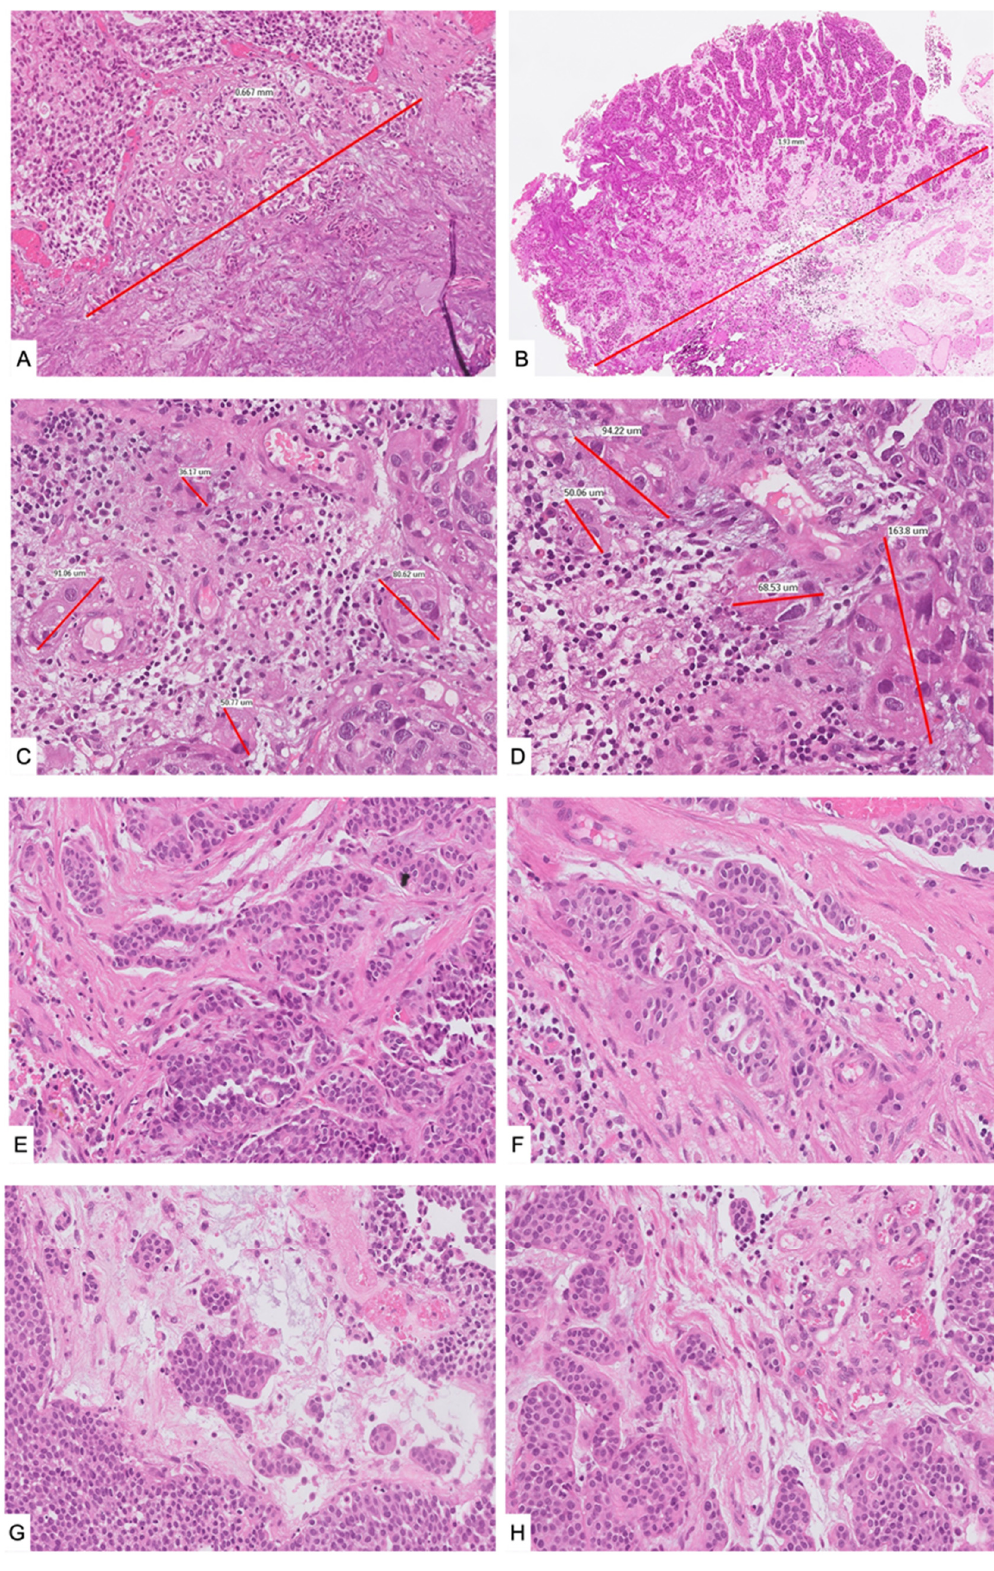
Figure 2. Examples of ROL substaging (Hematoxylin and Eosin). Single invasive foci measuring <1.0 mm (ROL1) (( A ), 20×) and >1.0 mm (ROL2) (( B ), 5×) at their greatest diameter in any direction. Multiple invasive foci of the same tumor extending together for <1.0 mm (ROL1) (( C , D ), 20×) and for >1.0 mm (ROL2) (( E – H ), 20×). ROL: Rete Oncologica Lombarda.